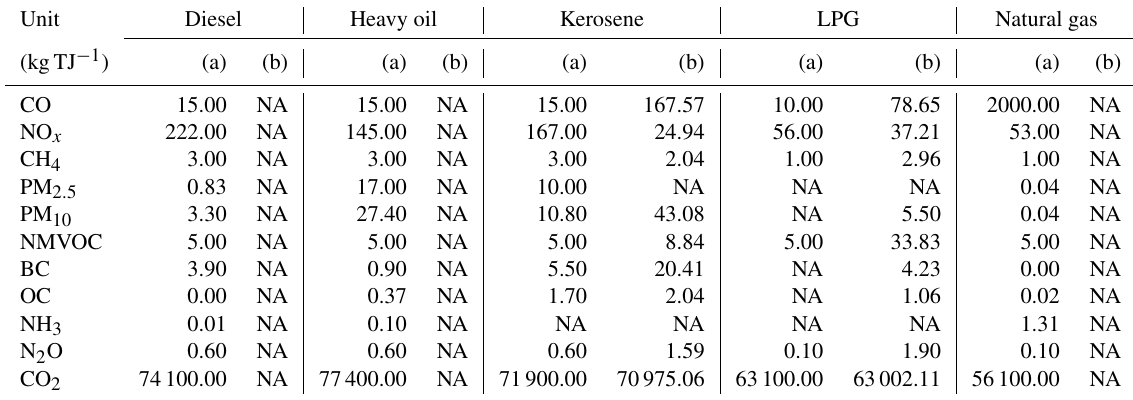
Table 7. Emission factors for manufacturing industry and construction (a) and residential (b) sectors from the compiled database provided by the Atmospheric Brown Clouds – Emission Inventory Manual (ABCEIM) by Shrestha et al. (2013). PM 2 . 5 and PM 10 were merged into PM for the residential sector in this database (except SO 2 ) (unit: kgTJ − 1